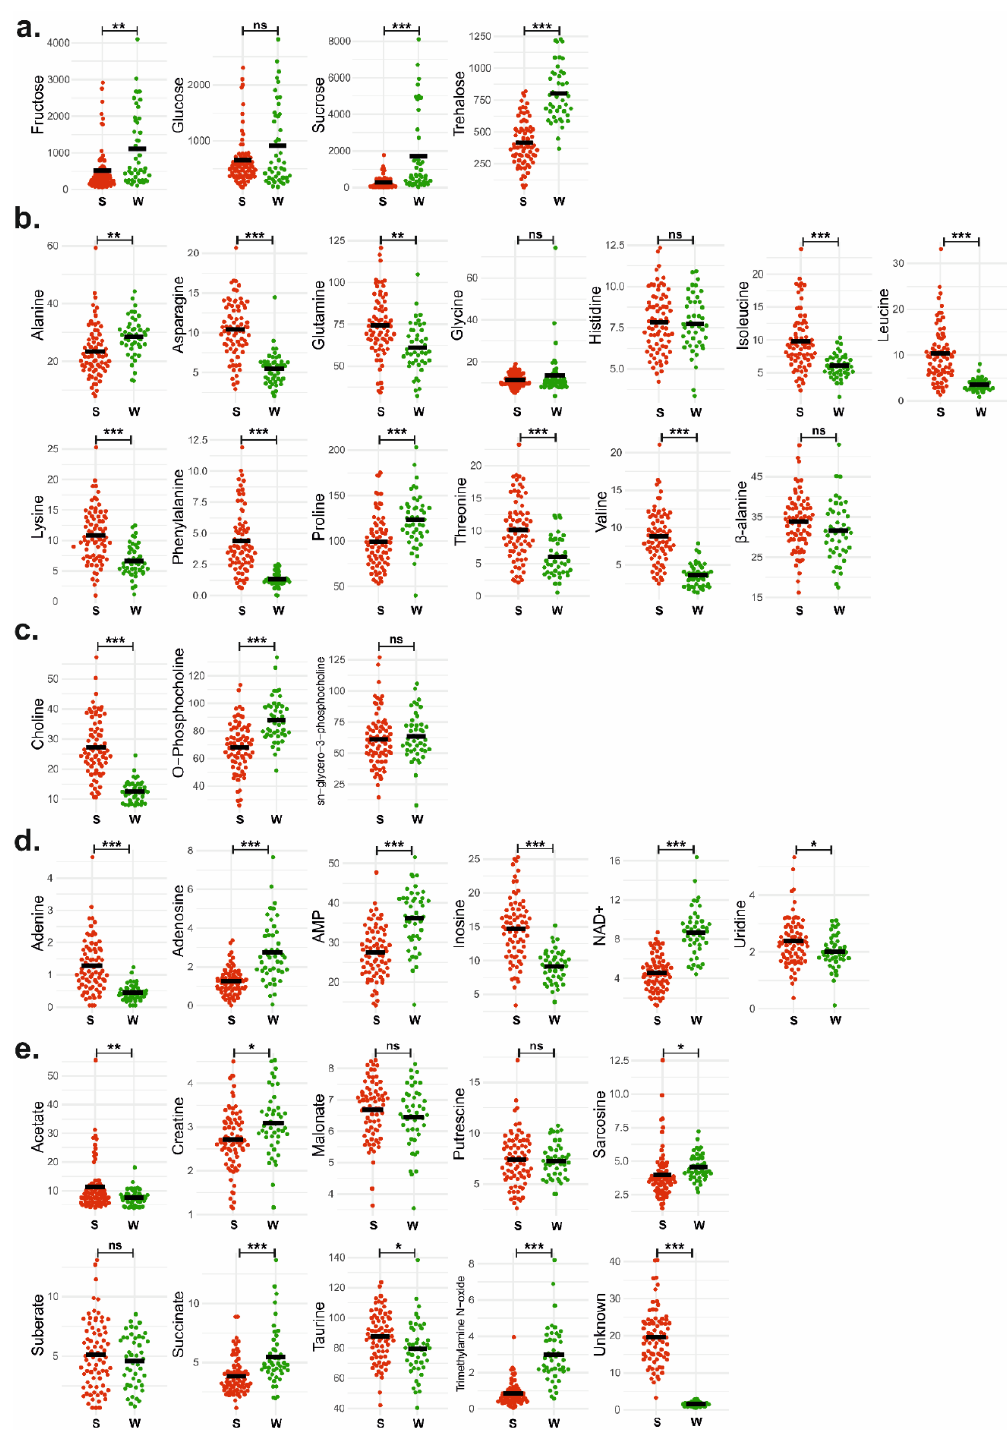
Figure 3. Comparison of 36 metabolites between summer bees and winter bees: ( a ) Carbohydrates; ( b ) Amino acids; ( c ) Choline-containing compounds; ( d ) Nucleoside, nucleotides, and nucleobases; ( e ) Others. X -axis: the groups summer (red) and winter (green), y -axis: metabolite concentration (μg/bee), black bar: mean. The P-values were obtained from the independent t -test. Asterisk indicates significant differences * p < 0.05, ** p < 0.005, *** p < 0.0001, ns = not significant. Benjamini–Hochberg’s procedure (false discovery rate, FDR 0.05) is applied after the independent t -test. Details of the independent t -test and Benjamini–Hochberg’s procedure informed in Table 1.